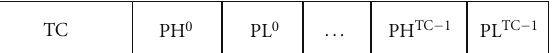
Figure 5: The secret header of